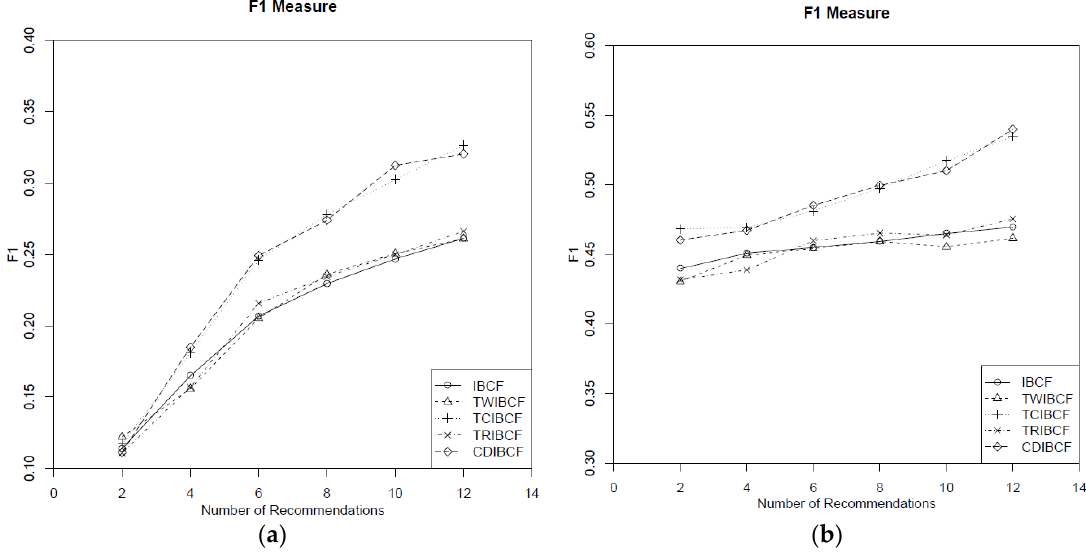
Figure 9. F1 results with MovieLens dataset ( a ) and Netflix dataset ( b ).